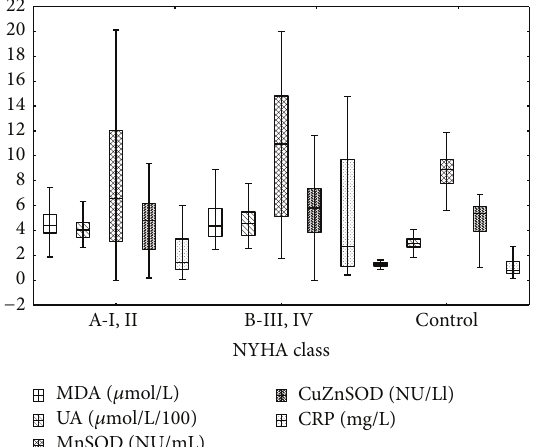
Figure 1: Redox and inflammation biomarkers in I, II and III, IV NYHA class patients and control. Median [25%–75%] and 1.5IQR.